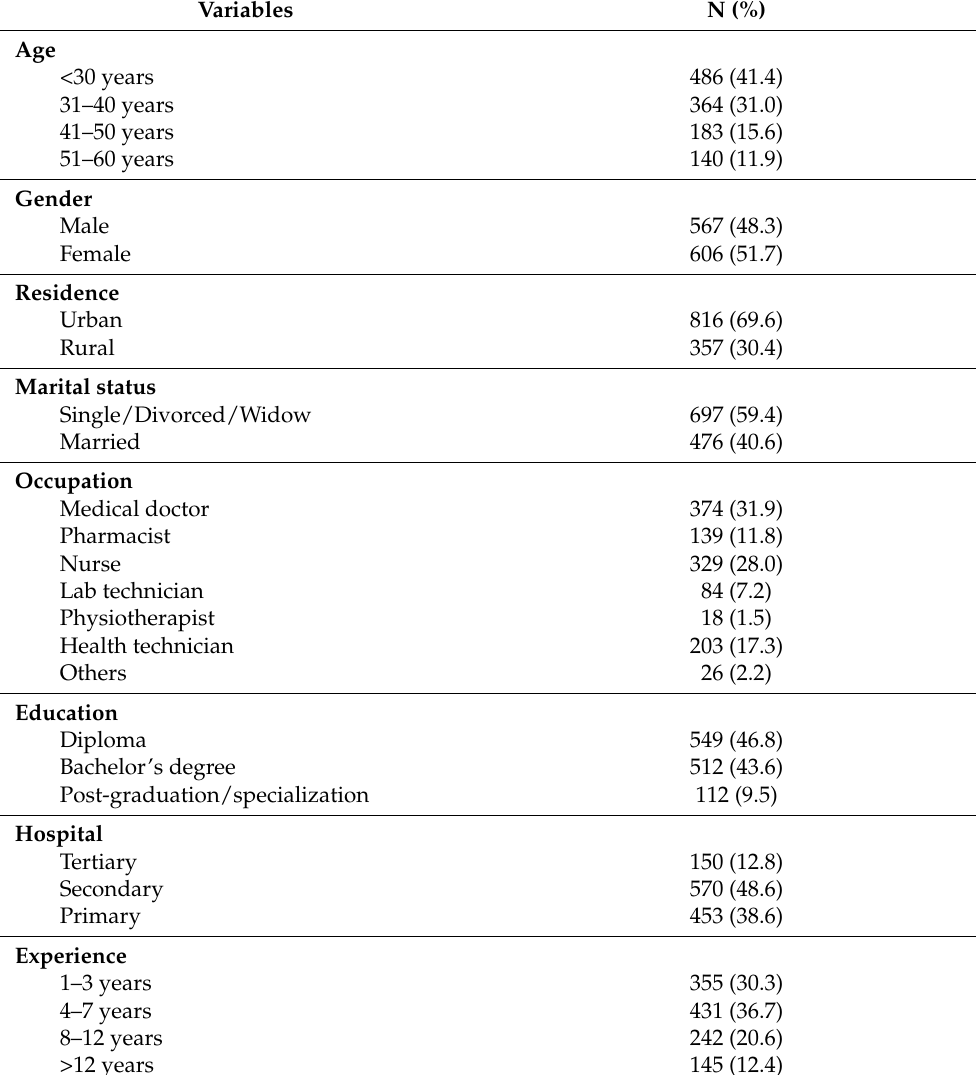
Table 1. Demographic details of the